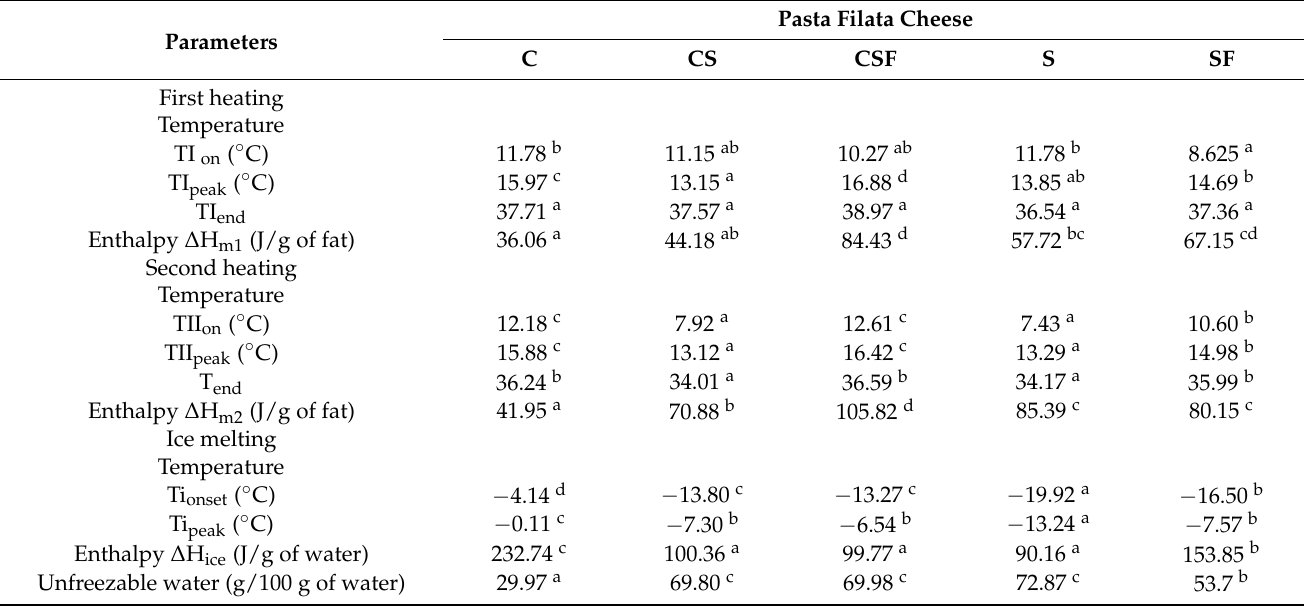
Table 5. Differential scanning calorimetry (DSC) parameters of pasta filata cheeses from cow’s and sheep’s unfrozen and frozen